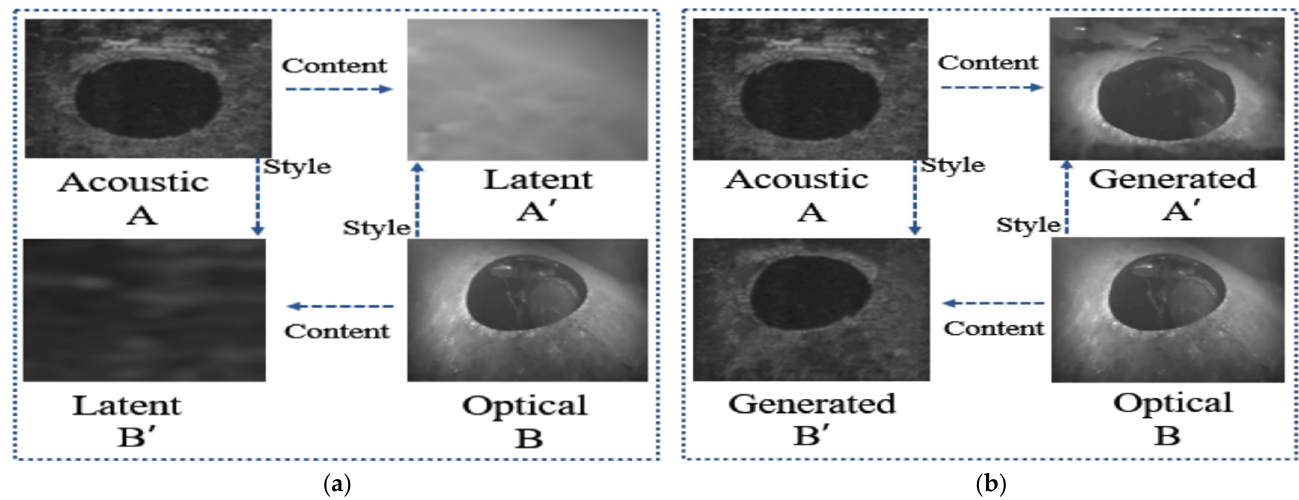
Figure 3. Visualization of underwater acousto-optic image attribute transfer: ( a ) the raw acoustic and optical image pair before image attribute transfer; ( b ) the acoustic and optical image pair after image attribute transfer.